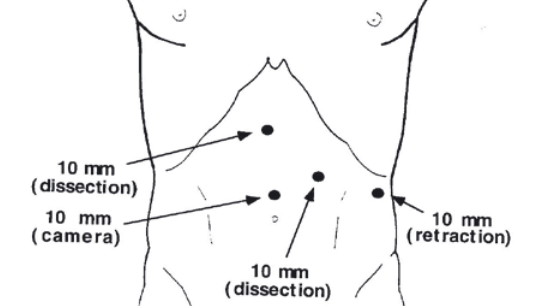
Figure 2. Troacar placement in